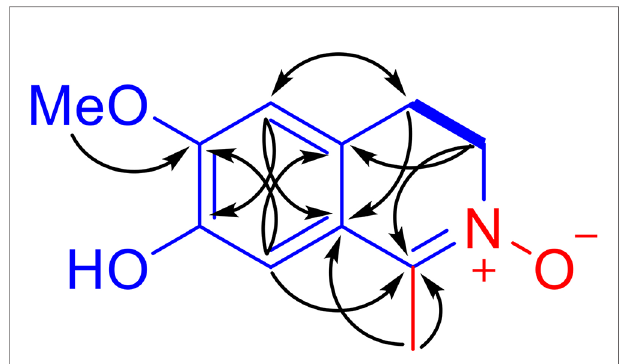
FIGURE 2 | Main 1 H- 1 H COSY (bold lines) and selected HMBC correlations (arrows, from 1 H to 13 C) of